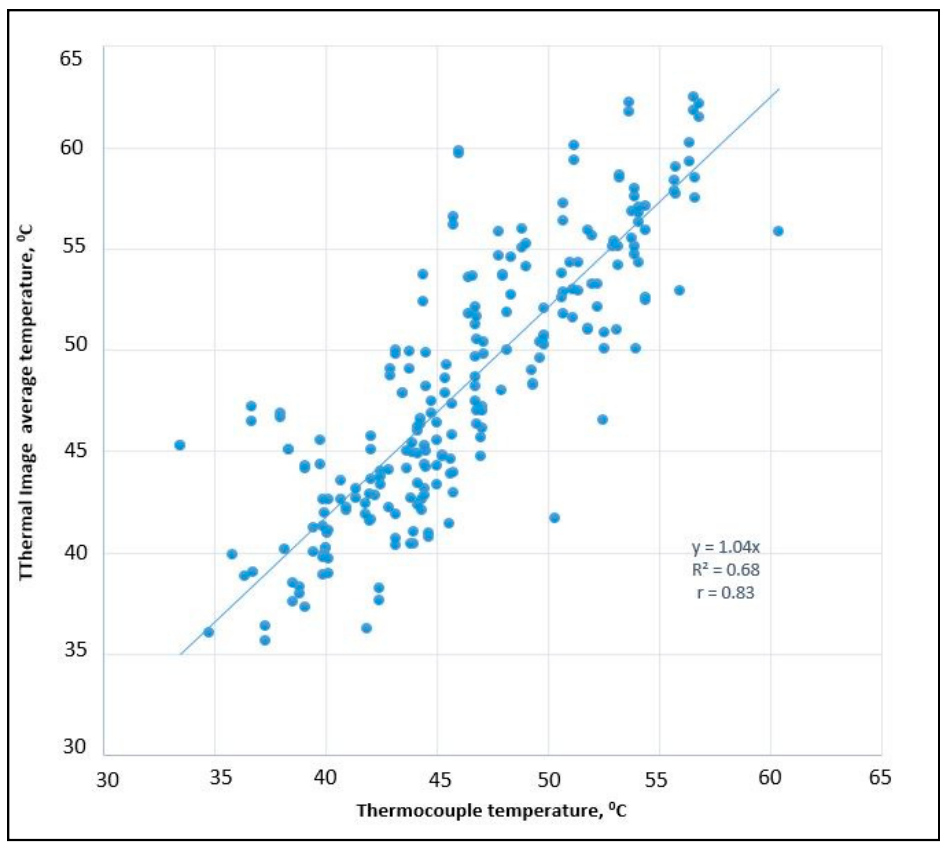
Figure 7. Surface thermocouple temperature correlation (all surface materials) versus thermal camera temperatures at outdoor field study site, Auburn University, Auburn, Alabama, 2013.